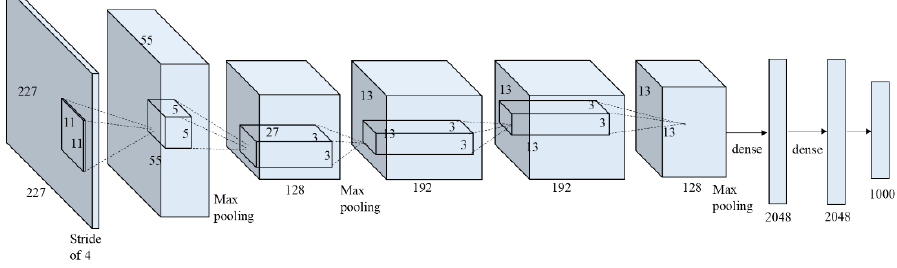
Figure 3. Overall architecture of AlexNet (redrawn from [30]).